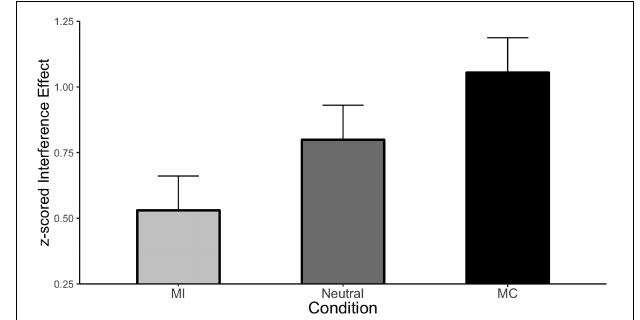
FIGURE 2 | ISPC effect in Experiment 1. Error bars represent the 95% HDI.